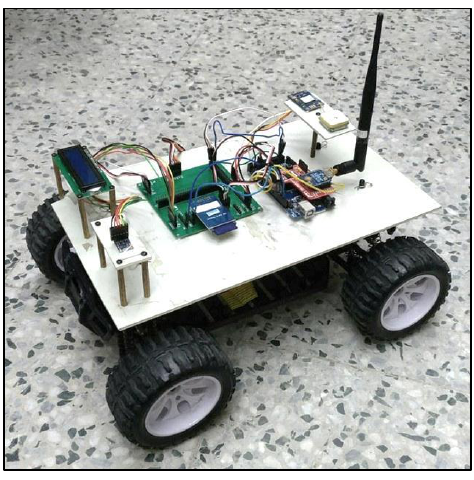
Figure 8. Experimental Robot Vehicle.